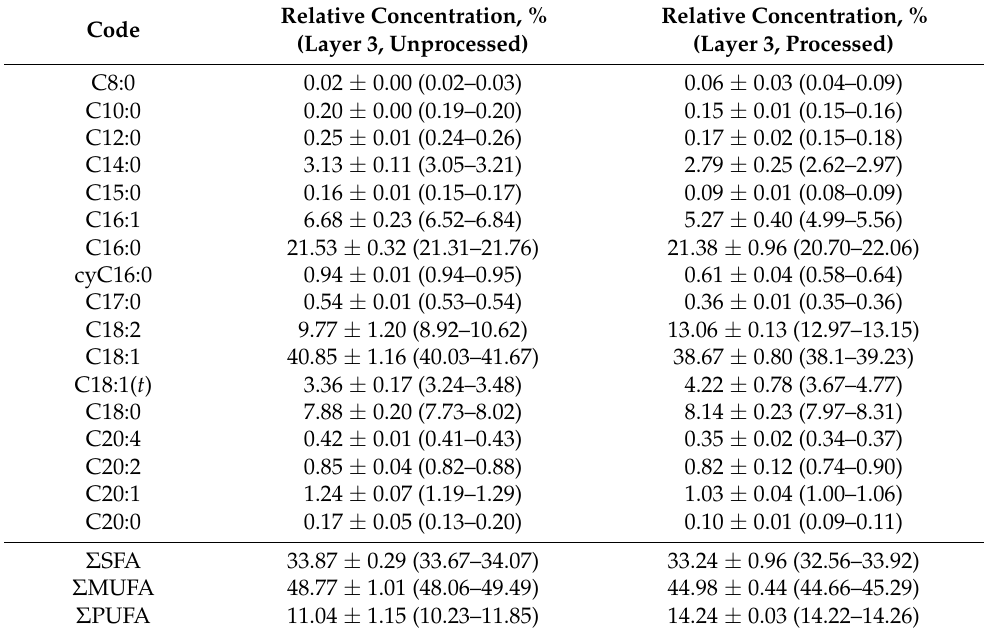
Table 4. Relative concentrations of the main FAMEs identified by GC-MS analysis in the raw (unprocessed) and thermally processed lipid fraction (layer 3, codes U3 and P3) from Mangalitza hard fat. Values are expressed as mean ± SD and data range (in